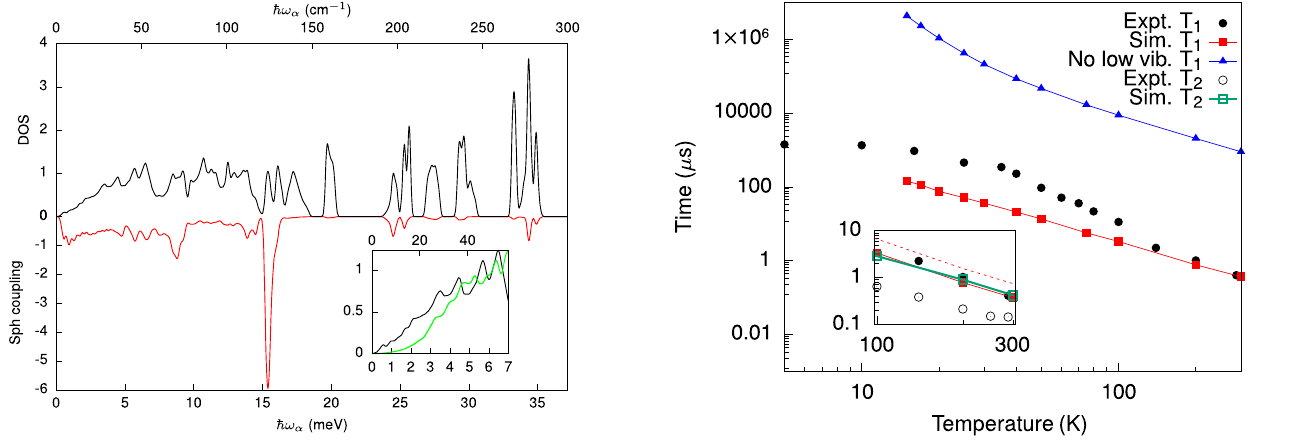
Fig. 5 | Spin-phonon relaxation and decoherence time. The computed spin- phonon relaxation time T 1 and coherence time T 2 (inset) are reported with a con- tinuous red line and full squares, and a continuous green line and empty squares, respectively. The theoretical limit T 2 =2 T 1 is reported with a dashed red line in the inset. The simulated T 1 after removal of all phonons with ℏ ω α <6 meV is reported withacontinuousbluelineand fi lledtriangles.Blackfull(empty)circlesareusedto reporttheinversionrecovery(Hahnecho)experimentalresultsofRef. 27 (errorbars are within the size of the